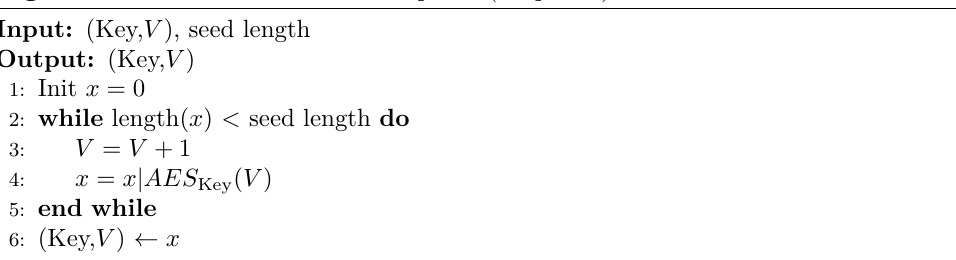
Algorithm 1 NIST CTR_DRBG _Update (simplified)